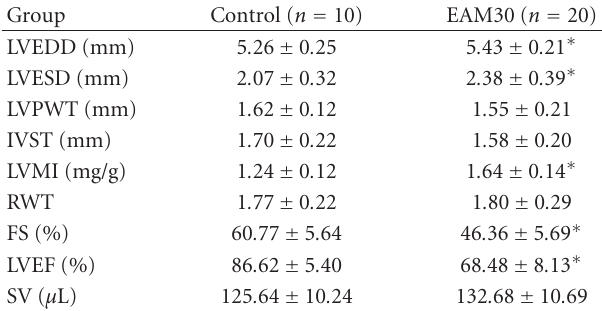
Table 1: Echocardiographic baseline data of control and EAM rats on day